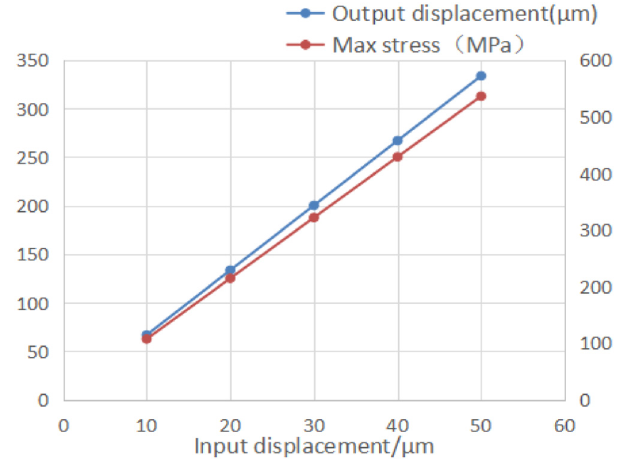
Fig. 8. The curves of input-output displacement and input displacement-maximum